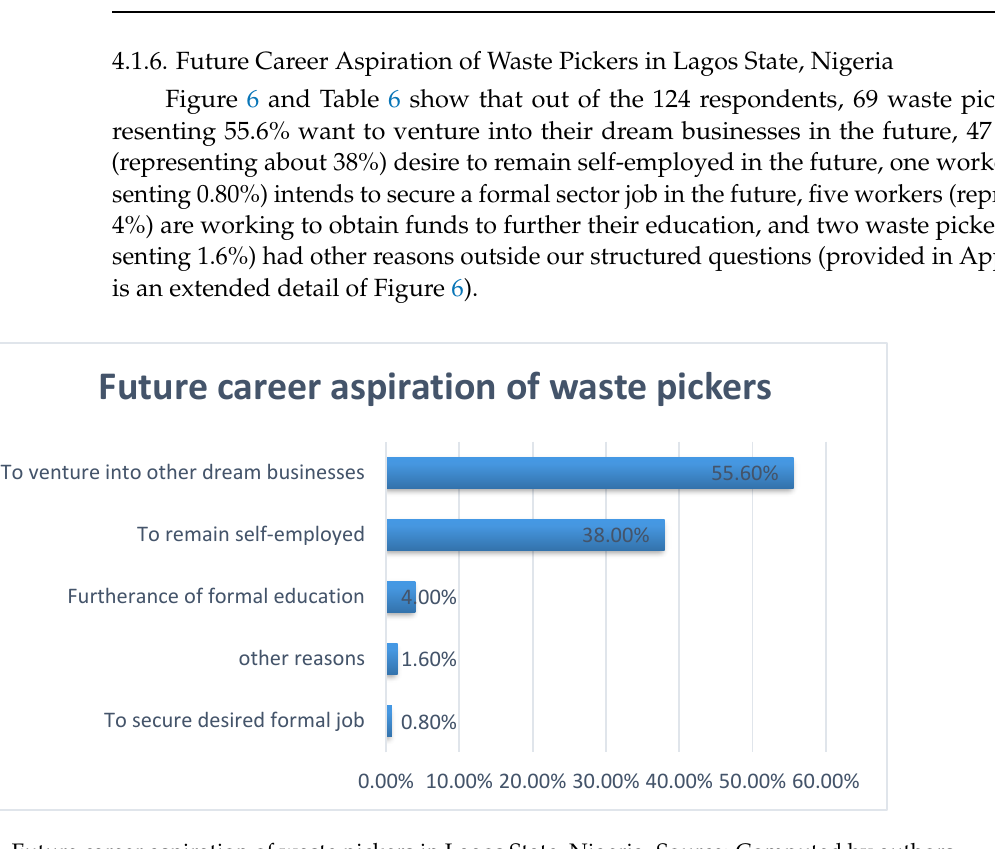
Table 6. Future career aspiration of waste pickers in Lagos State, Nigeria.